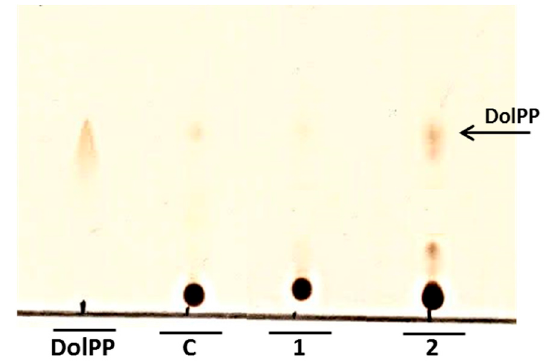
Figure 9. TLC analysis of DolPP in the extracts from the wild type C. albicans strain CAI4 (Line C) and CaCWH8/Cacwh8 ∆ (Line 1) and Cacwh8 ∆ /Cacwh8 ∆ (Line 2) mutants. Samples (25 µg of dry extracts each) were analyzed on Silica Gel 60 plate as described in Methods. Line DolPP line contains 2 ng of DolPP standard. Arrow indicates the DolPP spot in the extract from Cacwh8 ∆ /Cacwh8 ∆ mutant.